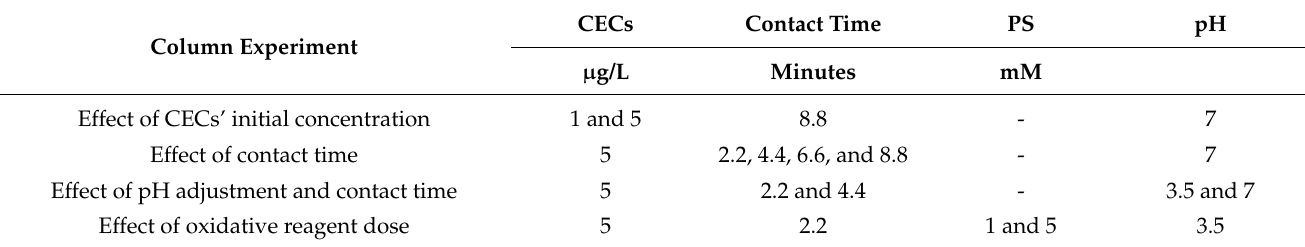
Table 3. Experimental conditions studied in the column